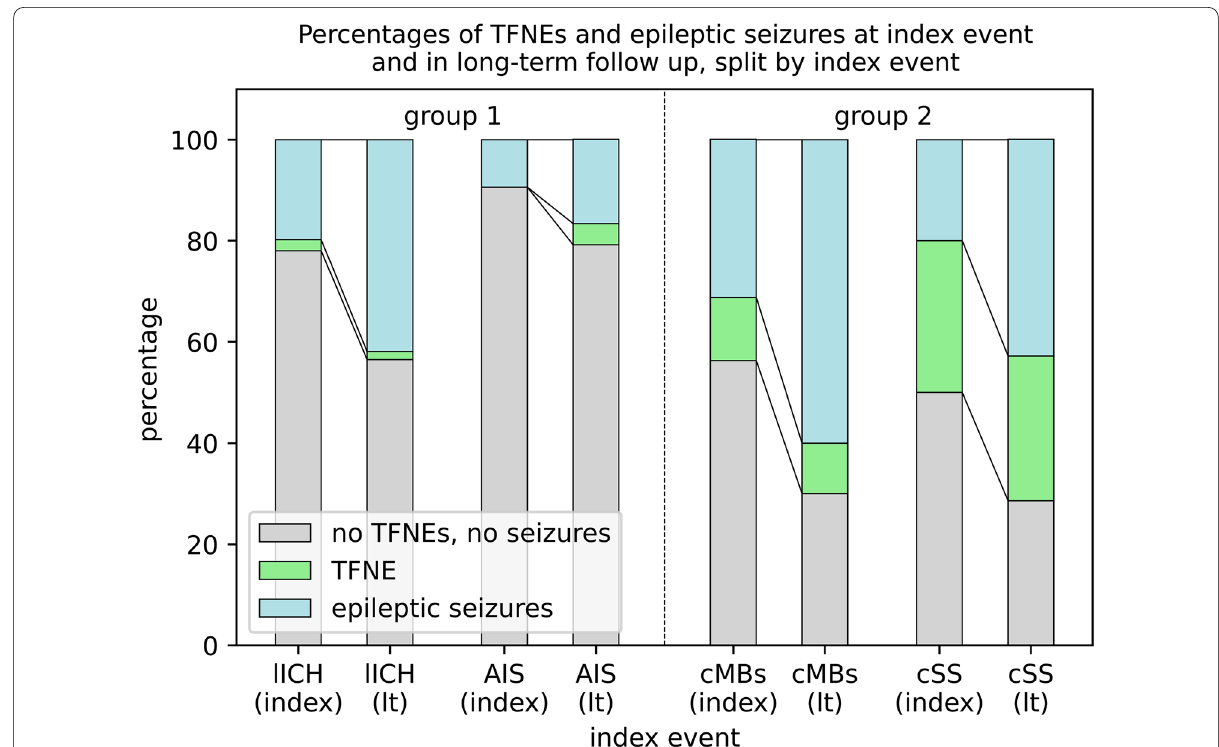
Fig. 1 TFNEs and epileptic seizures for each subgroup at index event and upon long term follow up. In all subgroups, the percentage of epileptic seizures increased over time while the percentage of TFNEs stayed constant. (index